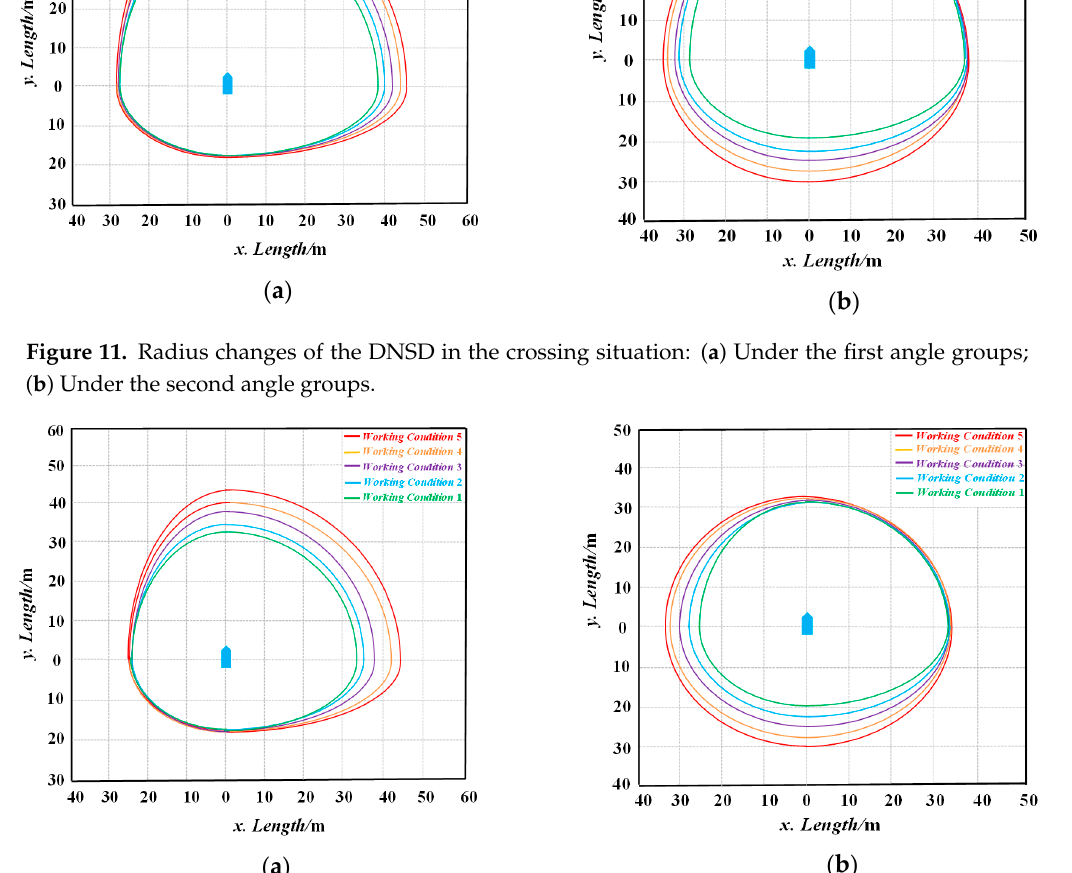
Figure 12. Radius changes of the DNSD in the overtaking situation: ( a ) Under the first angle groups; ( b ) Under the second angle groups.